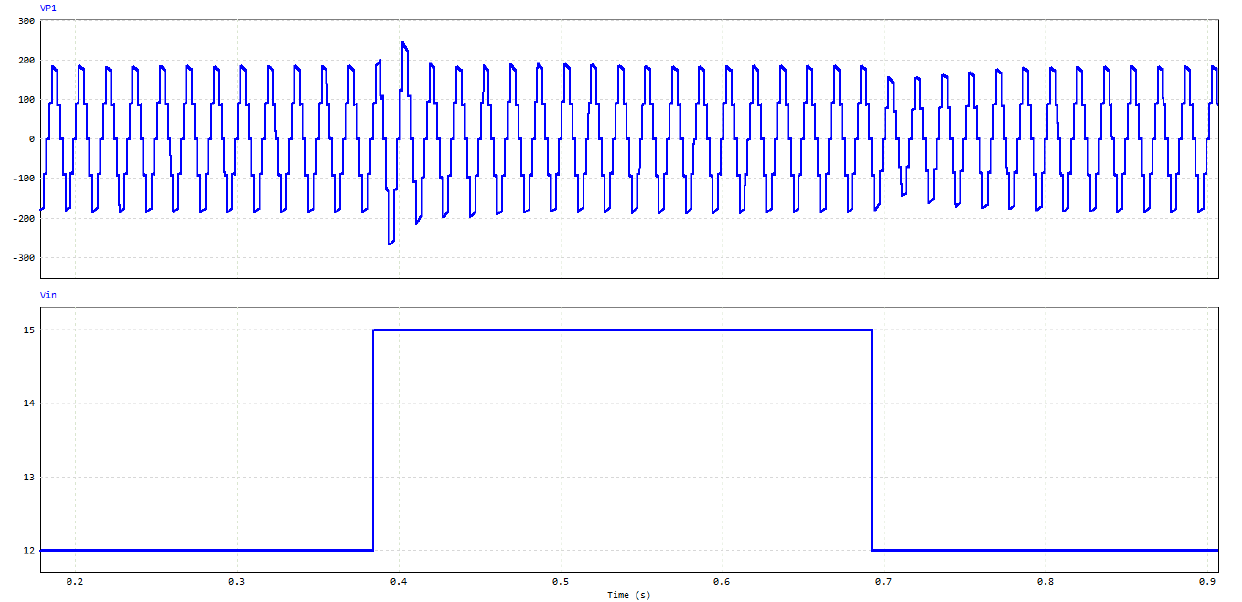
Figure 27. Operation of the converter under closed-loop control. Output voltage waveform when the